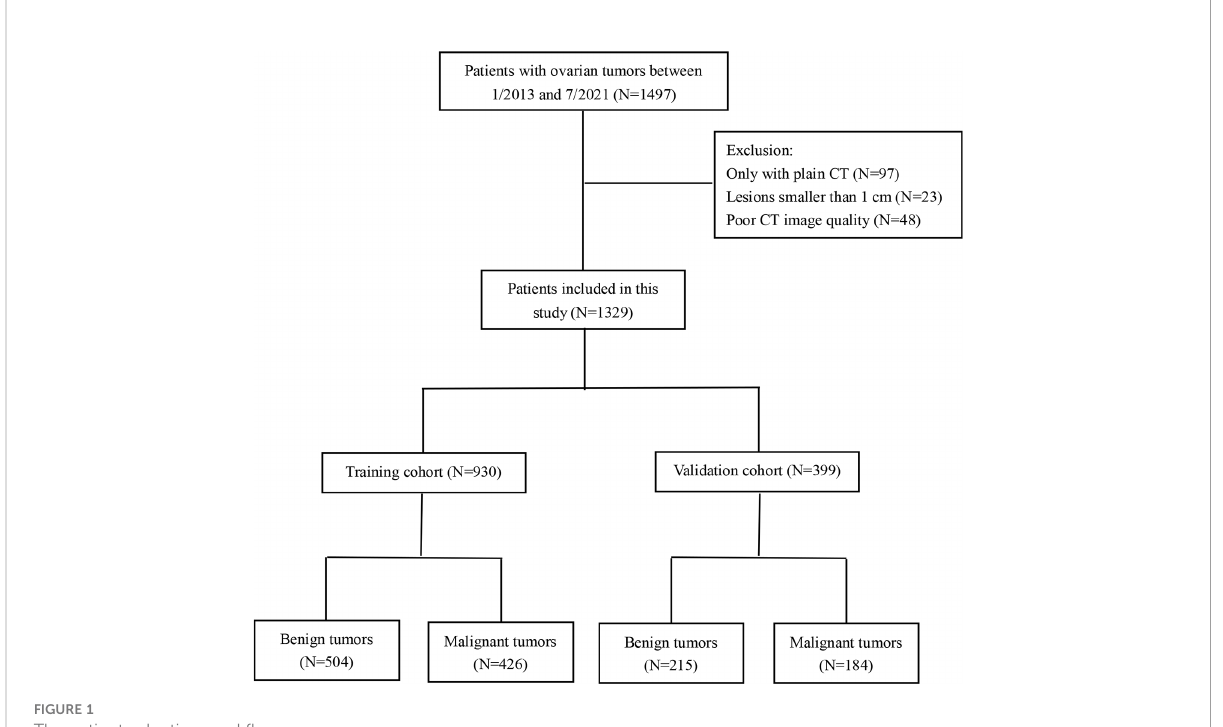
FIGURE 1 The patient selection work fl